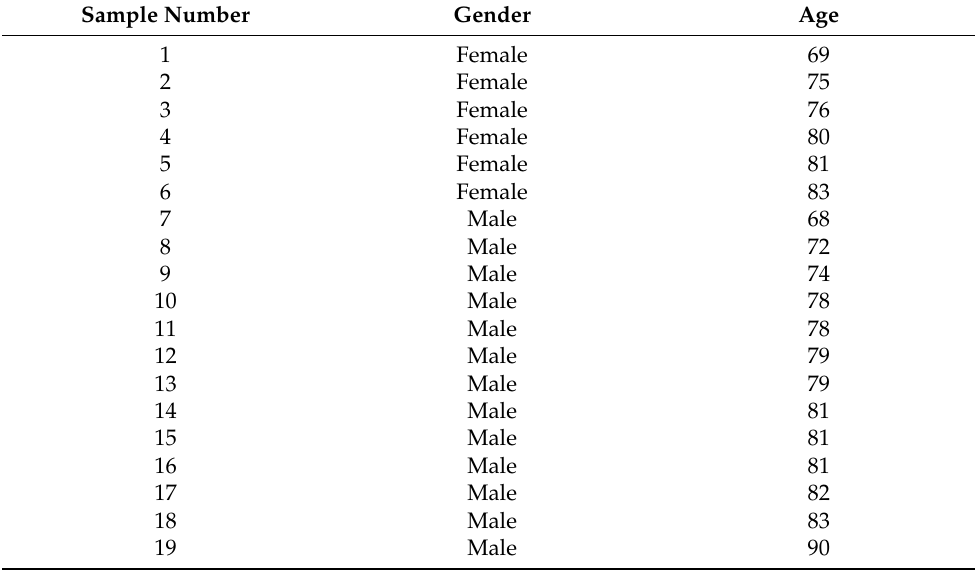
Table A3. Specimens included in the PD TMA.